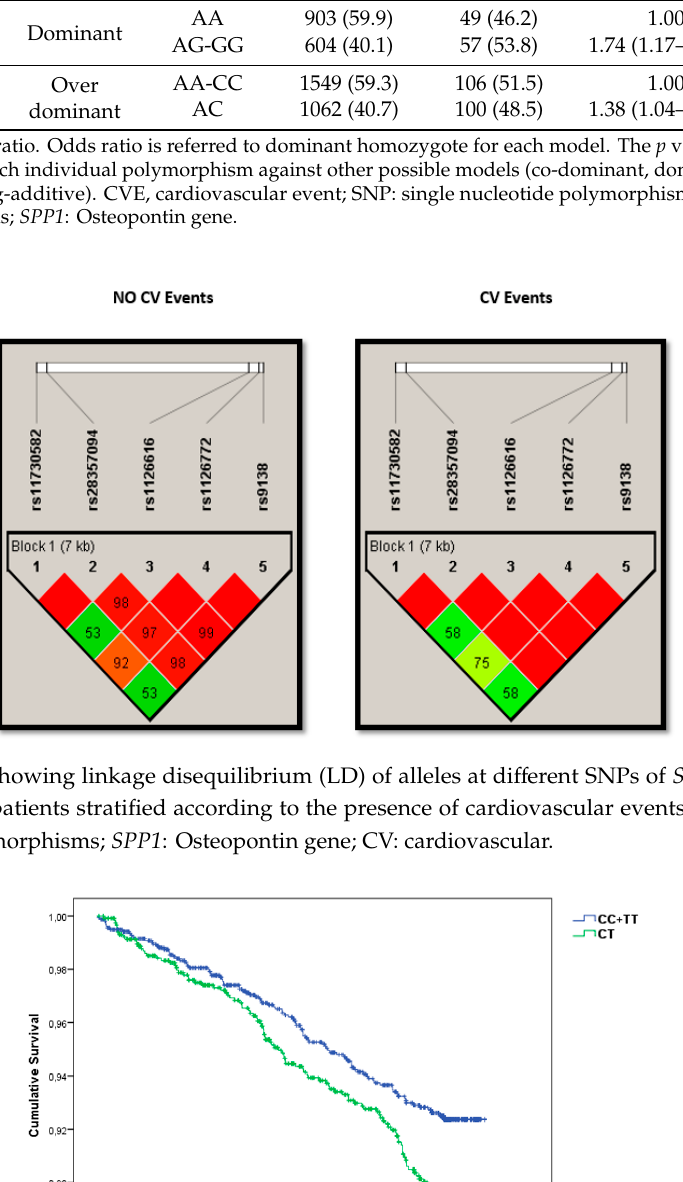
Figure 3. Circulating Osteopontin (OPN) levels stratified according to rs1126616 genotype and chronic kidney disease stage. Table 3. Association of SPP1 rs1126616 C > T polymorphism with epidemiological, clinical and biochemical parameters of the cohort. Variables